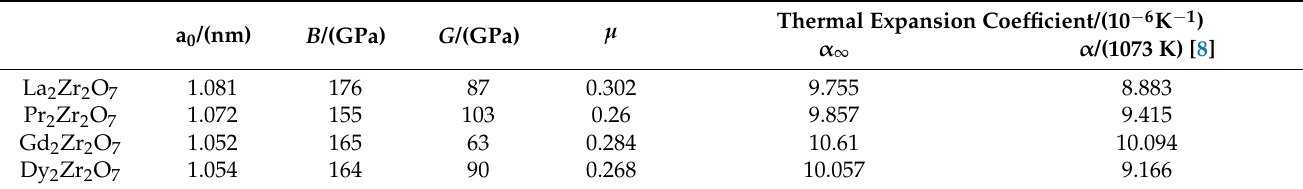
Table 3. Lattice constant a 0 , bulk modulus ( B ), shear modulus ( G ), Poisson’s ratio ( µ ) of rare earth zirconates system